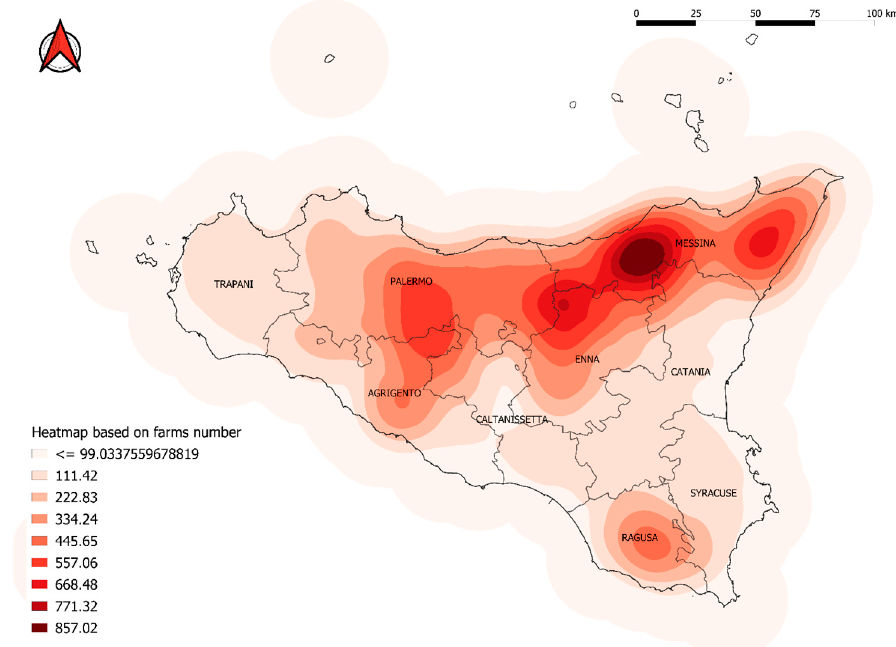
Figure 6. Sheep farm concentration at municipal level.